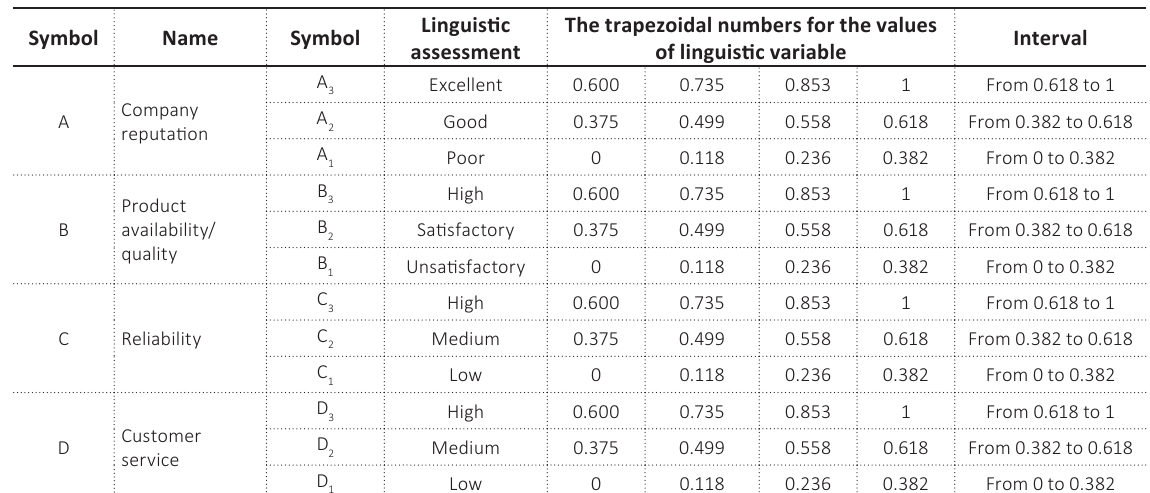
Table 2. Component assessments of the logistics service quality